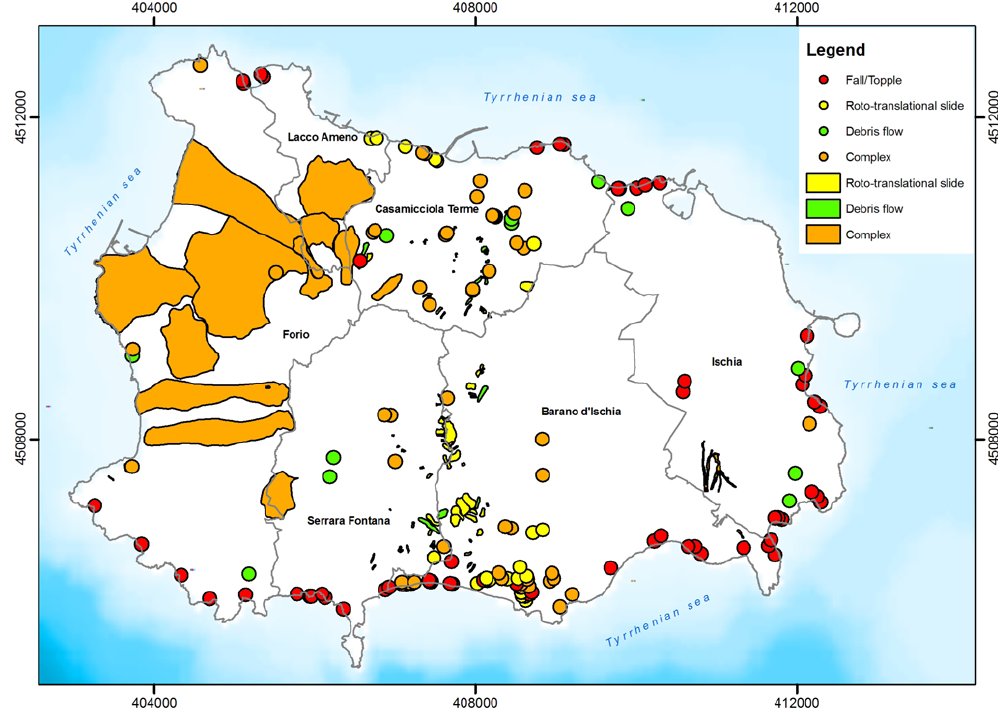
Fig. 10. Landslide-inventory map of the Ischia island. Submarine events are reported in Fig.